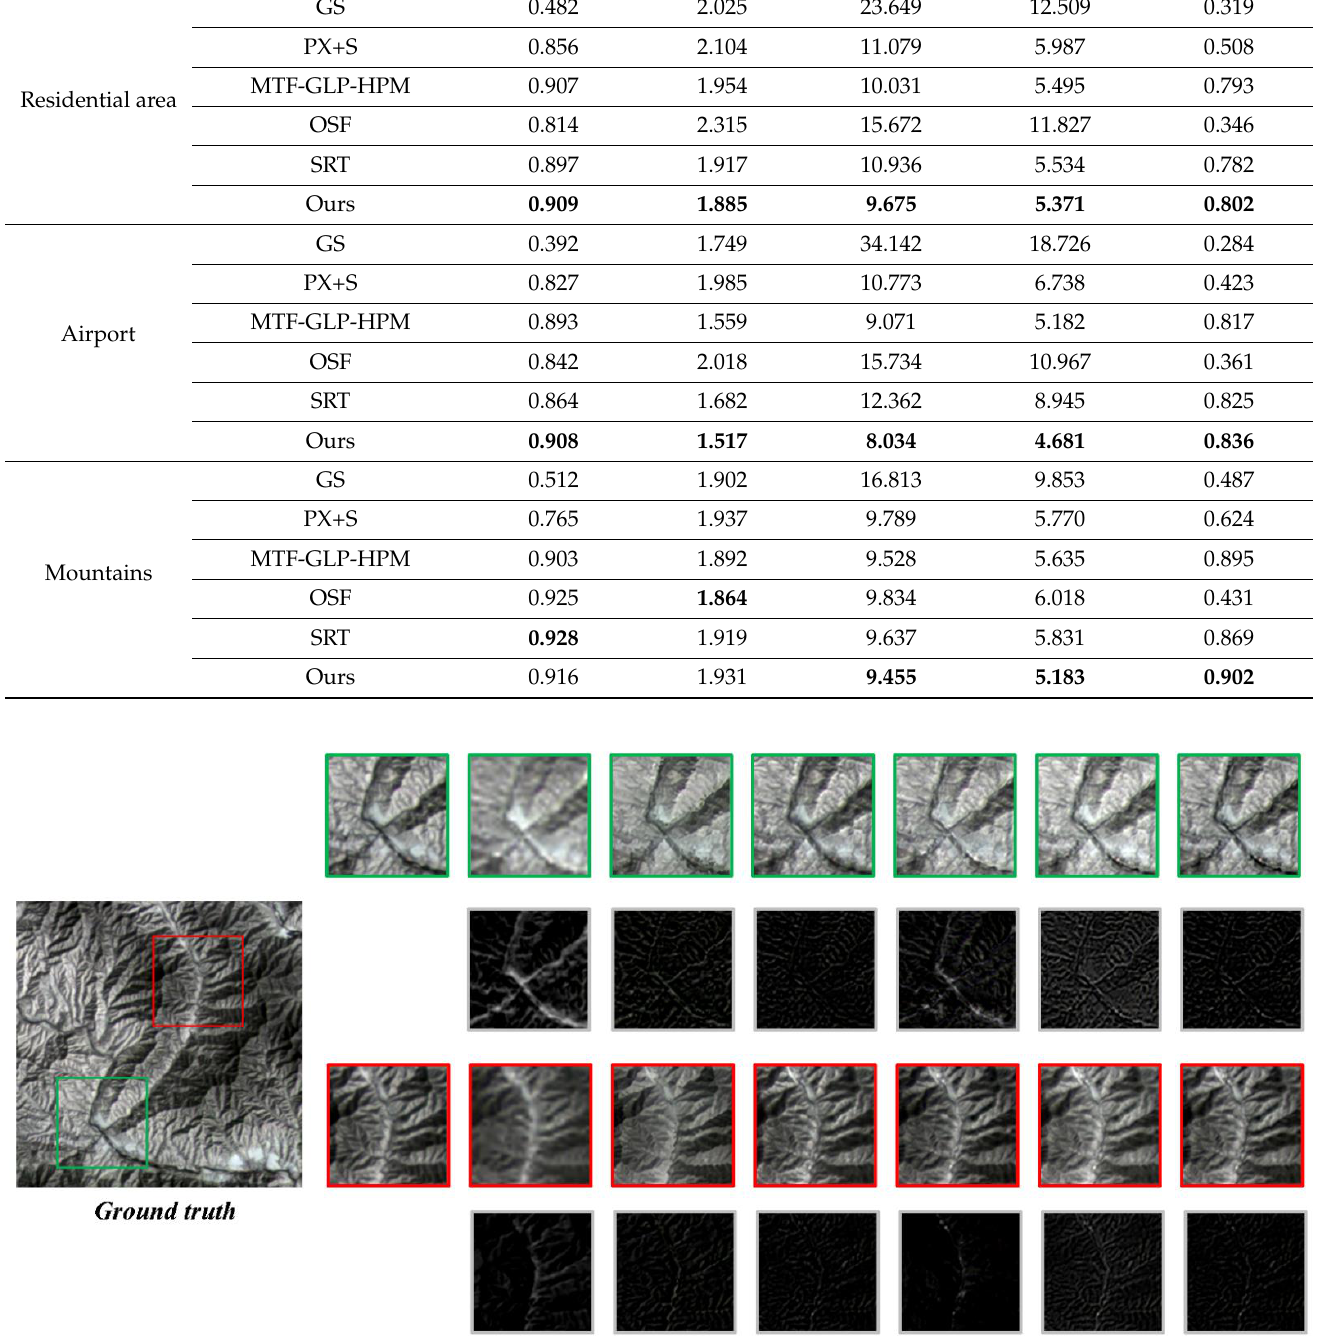
Figure 5. Comparison of fusion results of different algorithms on simulation data (the original image was taken in Beijing on 3 May 2022; scene: mountains).